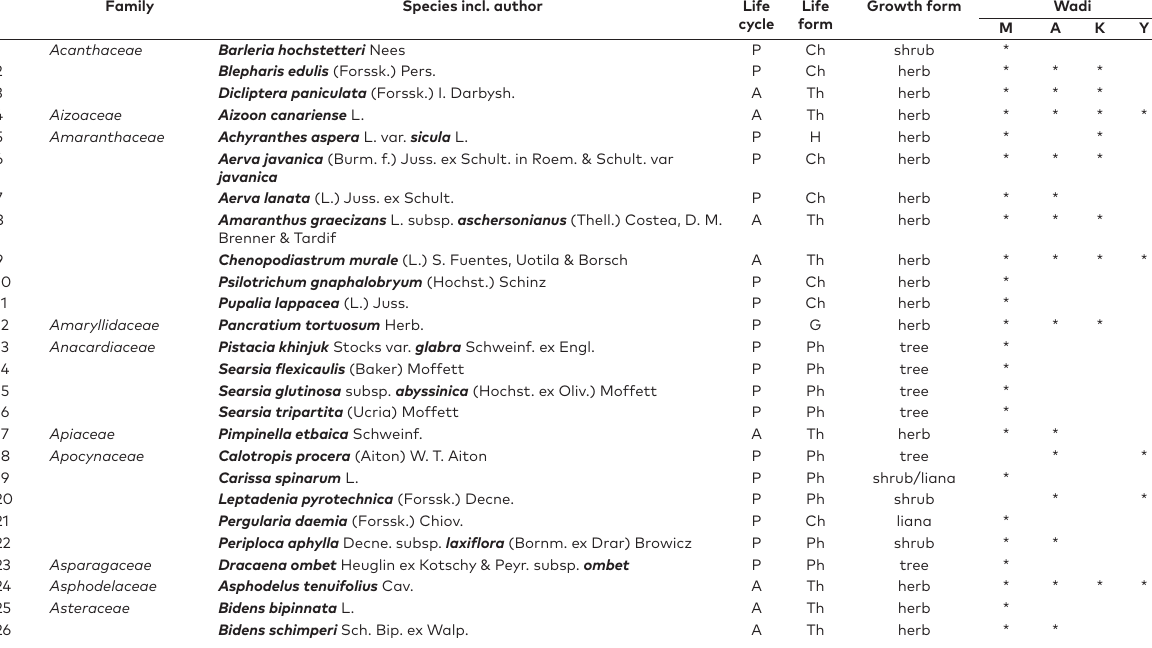
23 Asparagaceae Dracaena ombet Heuglin ex Kotschy & Peyr. subsp. ombet P Ph tree * 24 Asphodelaceae Asphodelus tenuifolius Cav. Th Asteraceae Bidens bipinnata L. Bidens schimperi Sch. Bip. ex